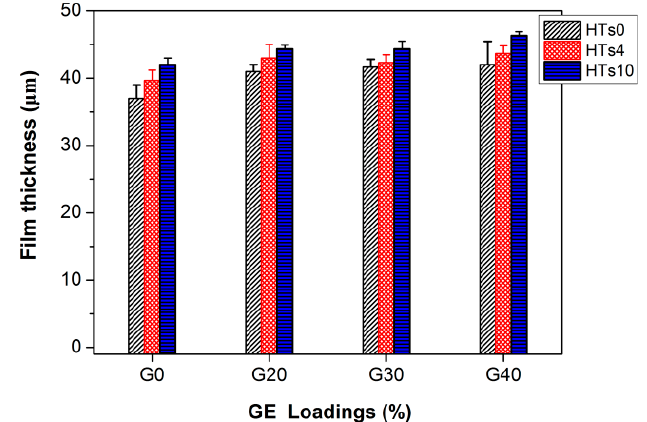
Figure 1. Film thickness of fish gelatin (FG)/glycerol (GE)/halloysite (HT) composites with various amounts of HT and GE